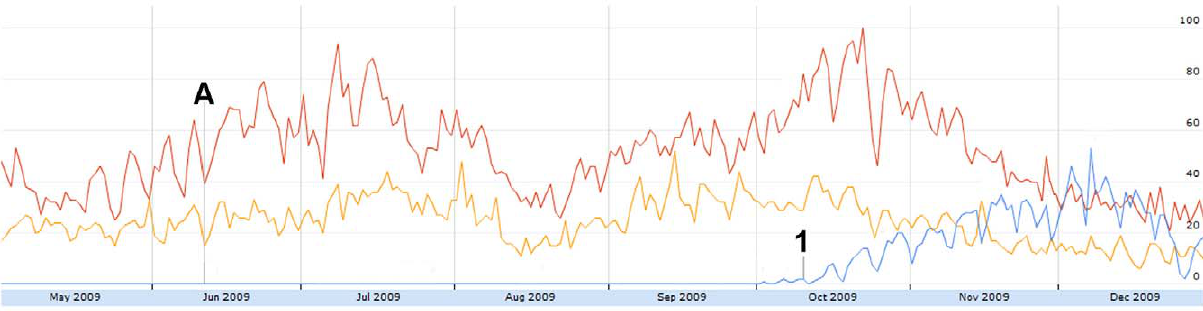
Figure 8. The relative proportion of tweets sharing personal experiences from May 1 to December 31, 2009. Figure was scaled to the highest peak on Oct. 20 where 5.64% of all tweets shared personal experiences. The peak was assigned a score of 100. Subconcepts: Red=indirect (family/friend) experience. Yellow=personal/direct experience. Blue=vaccination experience. A=June 11: WHO pandemic level 6 announcement. 1=Oct 6: H1N1 vacctionations arrive in the US.